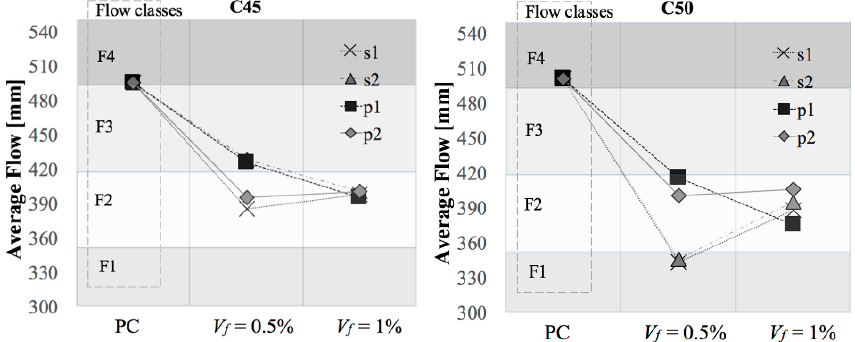
Figure 4. Influence of fibers on flow reduction in concrete C45 ( left ) and C50 ( right ) in case of plain concrete (PC) and fiber reinforced concretes ( V f = 0.5% and V f = 1%).